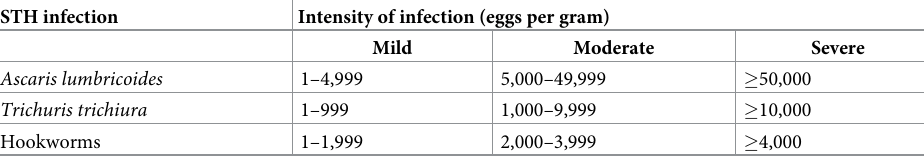
Table 1. Classification criteria for the intensity of infection of soil-transmitted helminths. STH infection Intensity of infection (eggs per gram) Mild Moderate Severe Ascaris lumbricoides 1–4,999 5,000–49,999 � 50,000 Trichuris trichiura 1–999 Hookworms 1–1,999 2,000–3,999 �